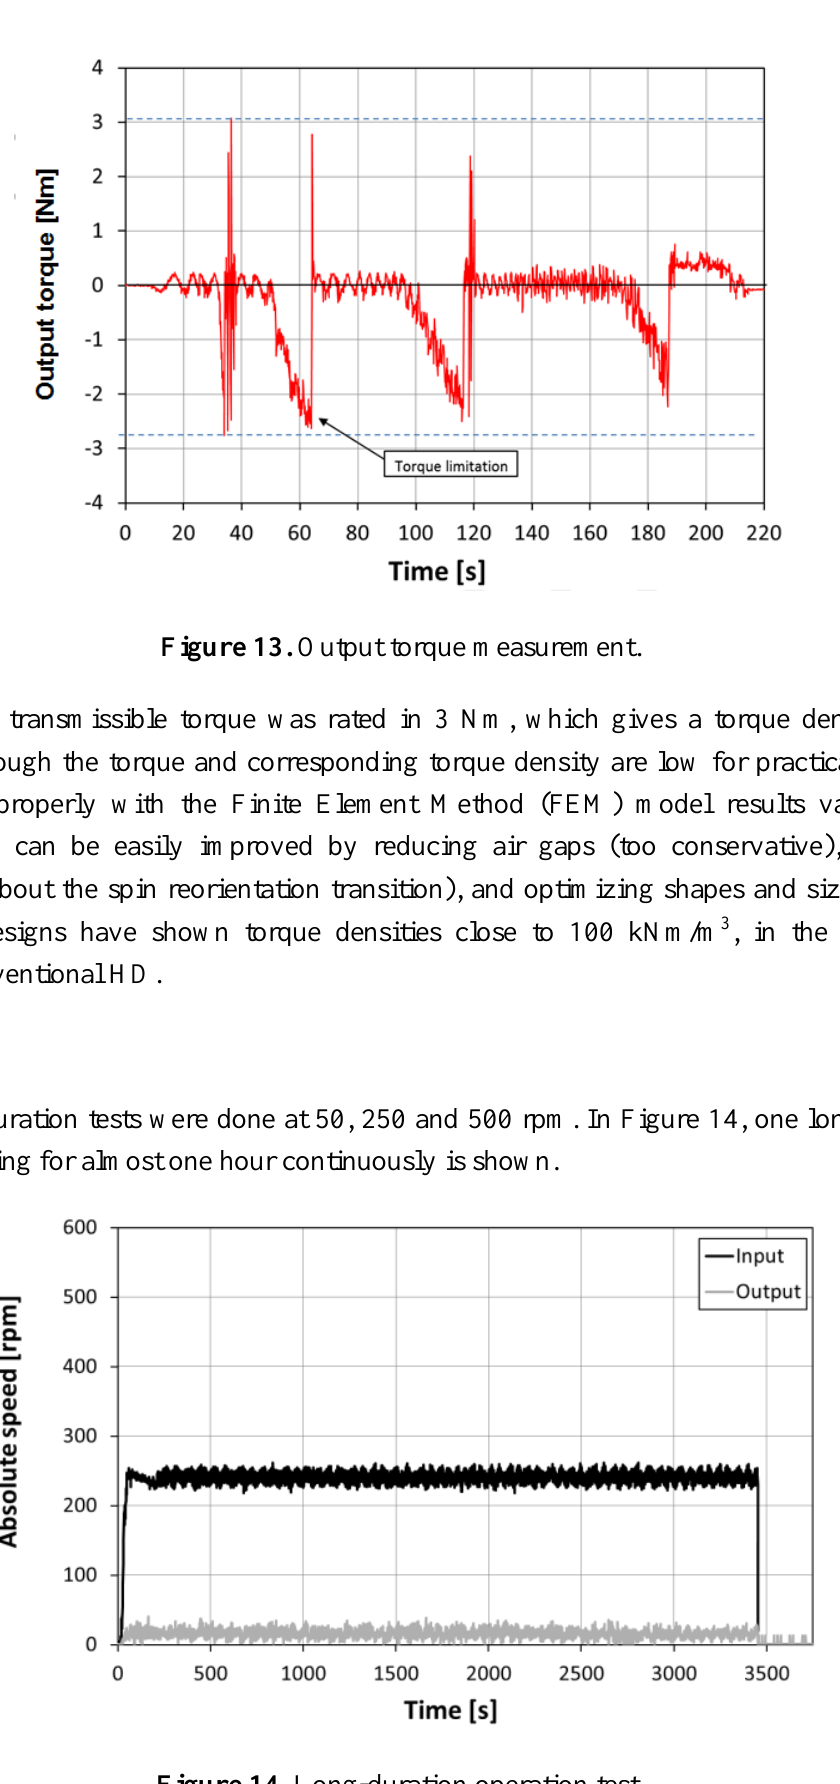
Figure 14. Long-duration operation